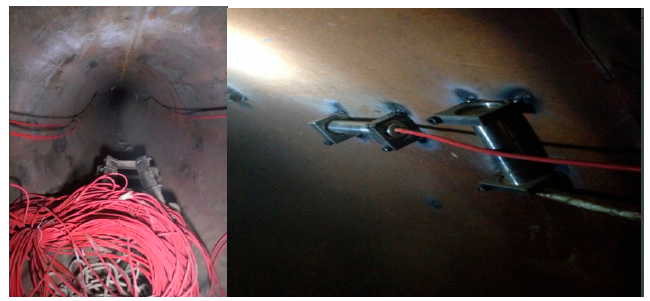
Figure 9. Installation of strain meter.